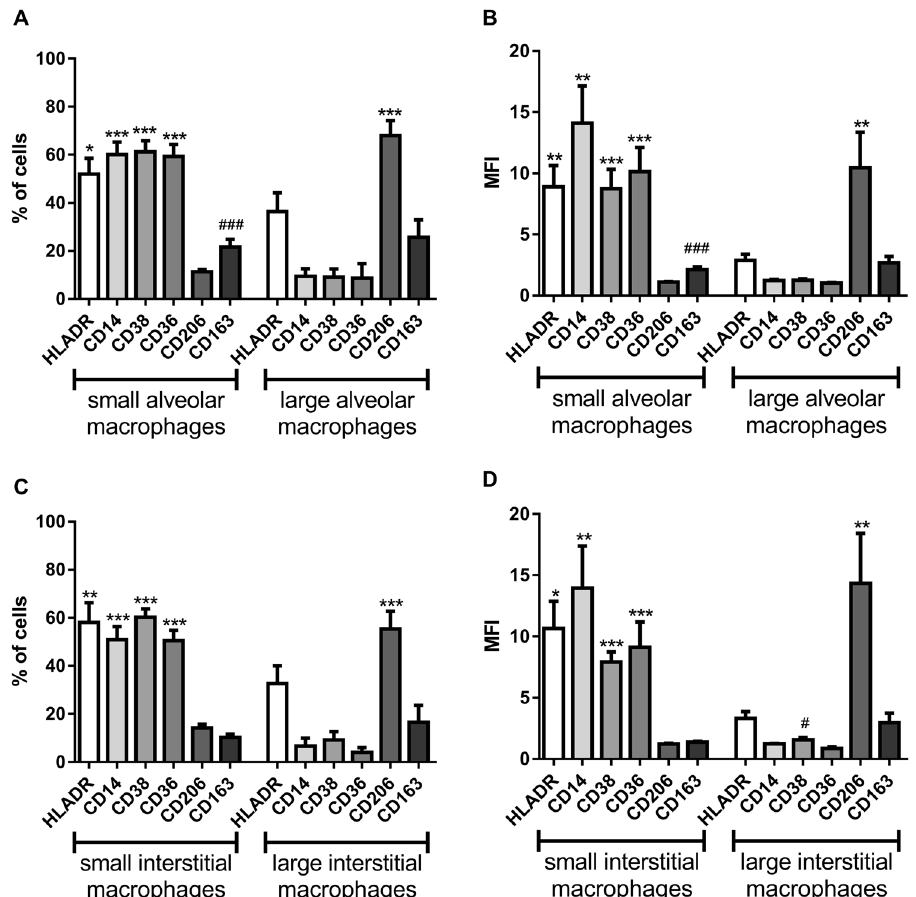
Figure 3. The expression of macrophage markers in small macrophages compared to large macrophages. Flow cytometric analysis of enriched alveolar ( A and B ) and interstitial ( C and D ) macrophages for n = 13 and n = 11 COPD patients respectively per marker. Markers analysed were HLA-DR, CD14, CD38, CD36, CD206 and CD163. Data is expressed as the percentage of cells within each subpopulation expressing a specific marker ( A and C ) and the median fluorescence intensity (MFI) of each marker ( B and D ) and represents mean (SEM). Paired t test (two tailed) was performed for each marker. * , ** , *** Significantly increased between size populations within tissue compartment (p < 0.05, 0.01 and 0.001 respectively). #,##,### Significantly increased between tissue compartments for each size population (p < 0.05, 0.01 and 0.001